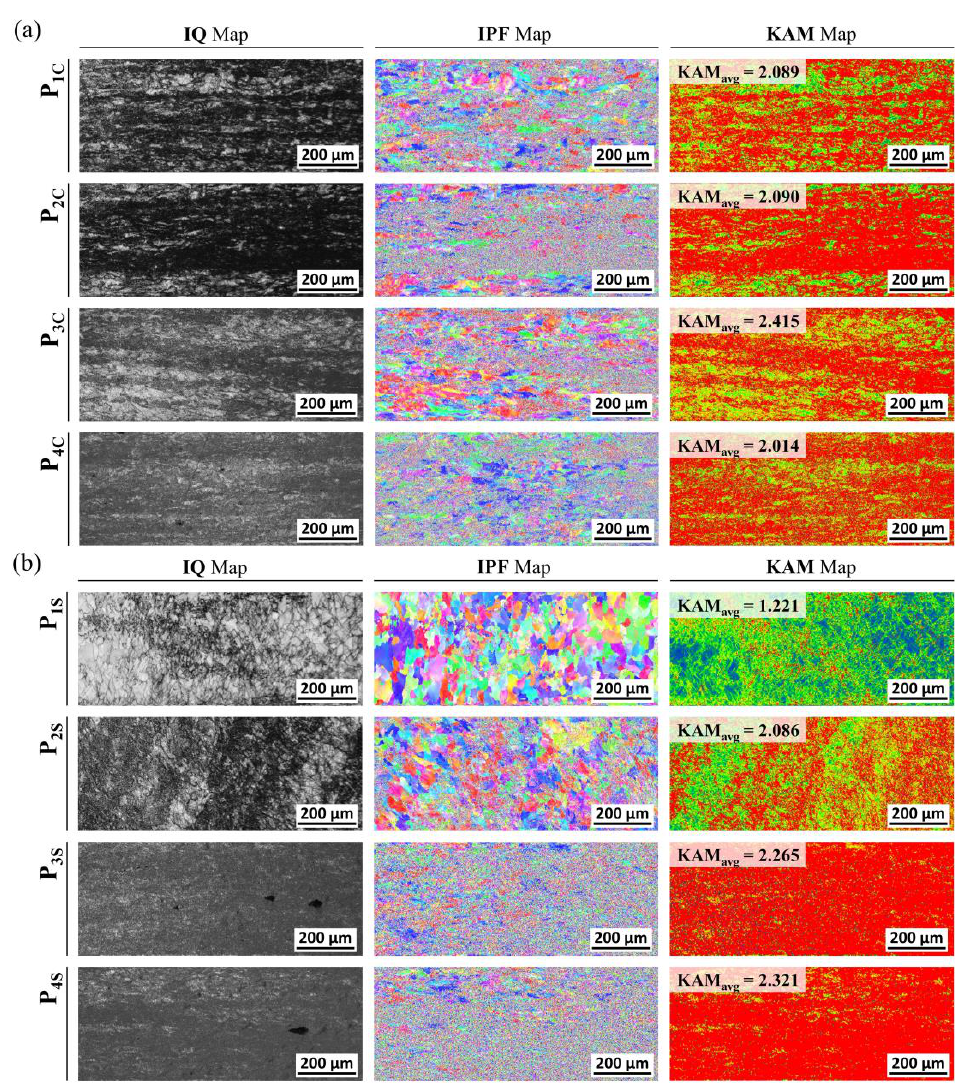
Figure 20. EBSD IQ map and IPF map, and KAM map: ( a ) on central core regions; ( b ) on near outer surface regions.